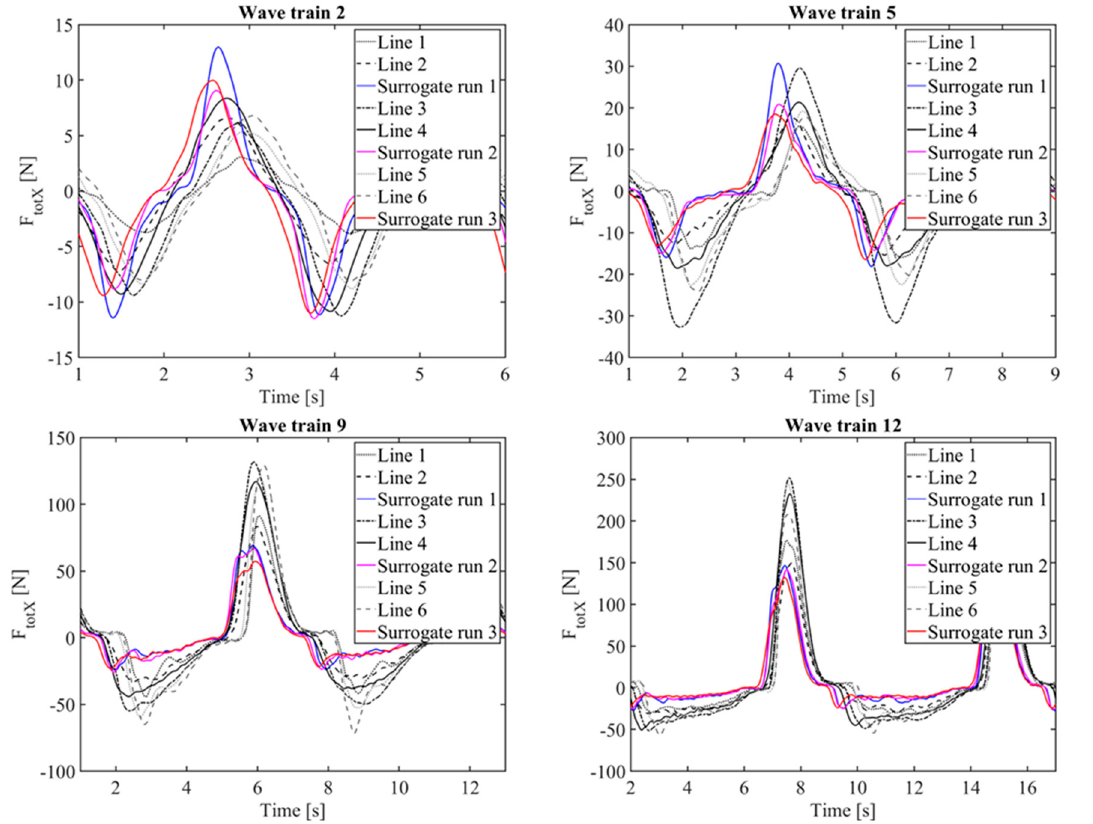
Figure 10. Time history of total force in x-direction for example wave cycles of trains 2, 5, 9 and 12. Force peaks of each individual wave (wave-per-wave maxima) are determined and used to evaluate the force response of the surrogate, as compared to the live dropper